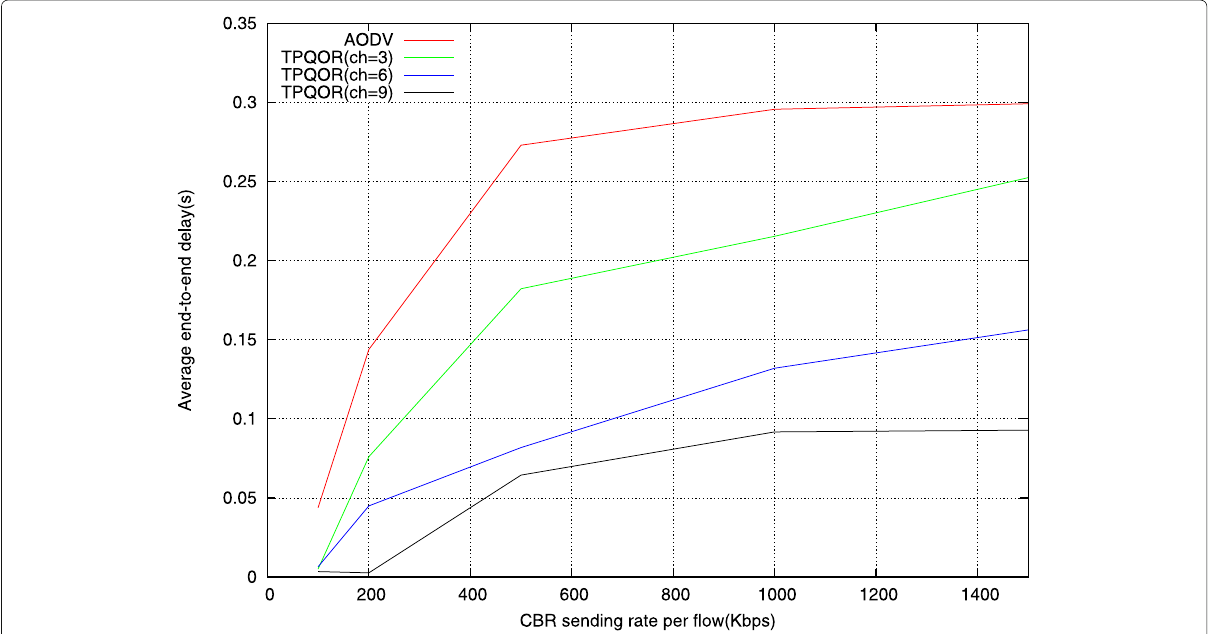
Fig. 8 Average end-to-end delay at different